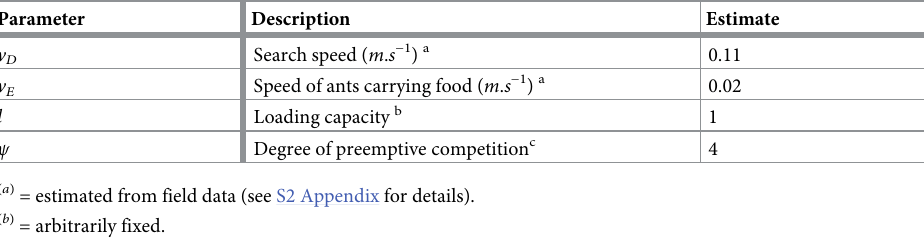
Table 2. Foraging parameters.